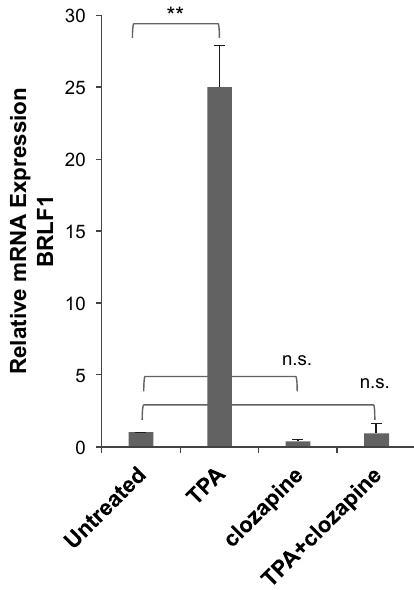
Figure 6. Clozapine inhibited EBV lytic BRLF1 expression in Raji cells. BRLF1 expression was measured in Raji cells after treatment with TPA (20 ng/mL) for 24 h in the absence and presence of clozapine (50 μ M). The average BRLF1 expression of three or more biological replicates for each of the treated conditions was compared to untreated cells. Treated conditions are marked not significantly different (n.s.) or different with p -value < 0.01 (**) compared to untreated.